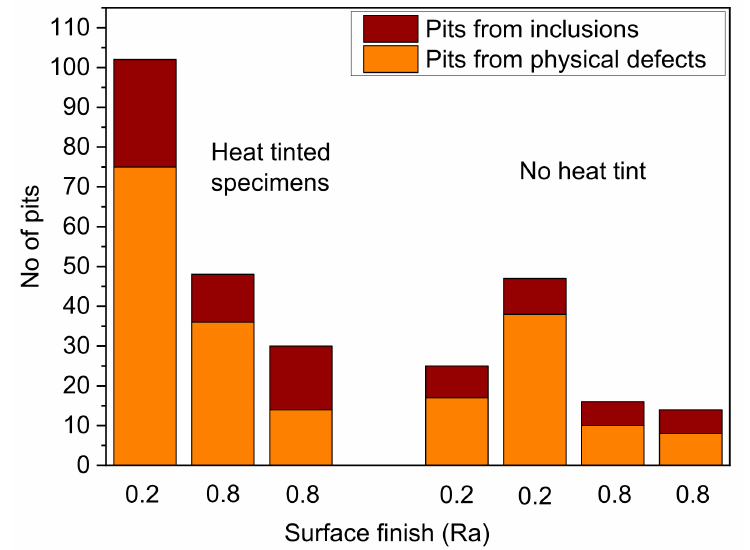
Figure 3. Comparison of number of pits associated with inclusions relative to physical defects in 316L SS in simulated oilfield environments. Reprinted with permission from [9] Copyright 2013 Crown